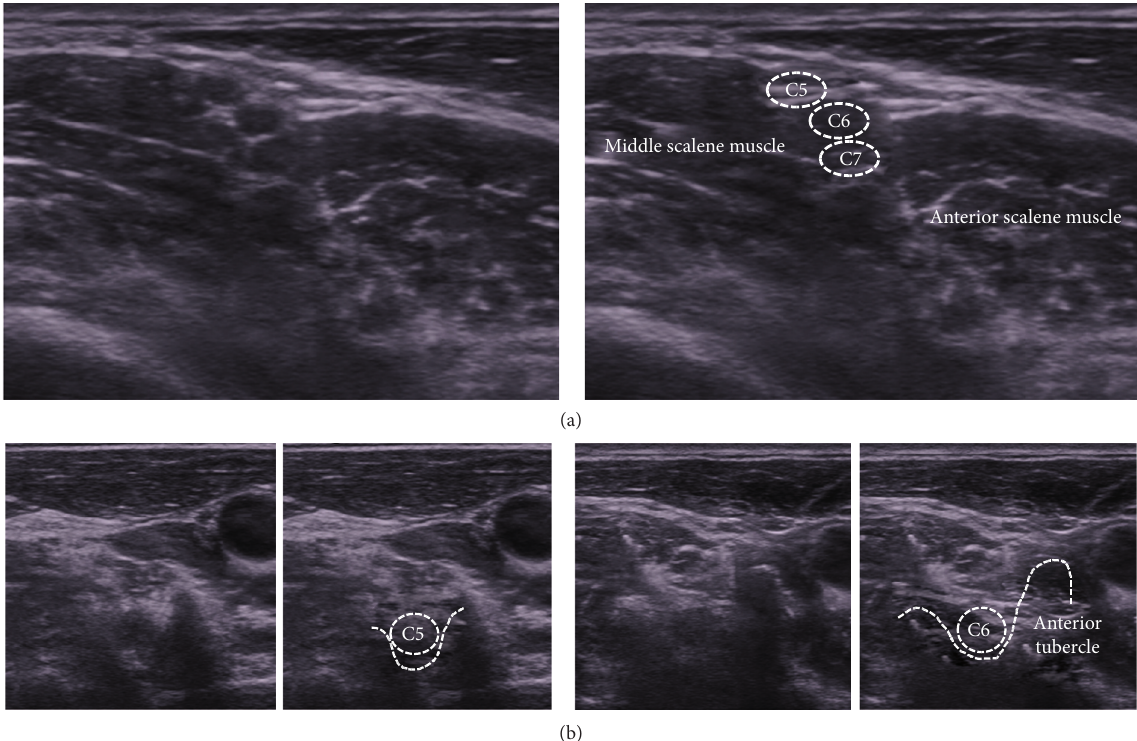
Figure 3: (a) In the short-axis view of the interscalene, the C5–C7 nerves depicted as straight three circular hypoechoic images between the anterior and middle scalene muscles are visualized. (b) The groove of the C5 transverse process between the anterior and posterior tubercles is U-shaped. The C6 anterior tubercle is large, so the groove of the C6 transverse process is J-shaped. The C5 and C6 nerves lead to the peripheral side through the groove of the transverse processes. Tracing the nerves depicted as circular hypoechoic images from the groove of the transverse processes to the peripheral side is useful for identifying the nerves at the interscalene.